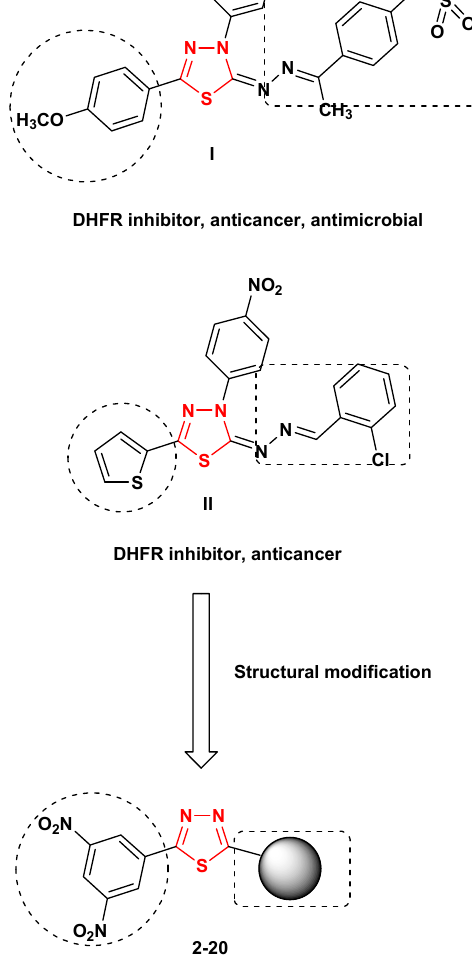
Figure 2. Structures of previously reported 1,3,4-thiadiazoles I , II with DHFR inhibitory activity and the strategy employed for designing the lead compounds 2 – 20 .